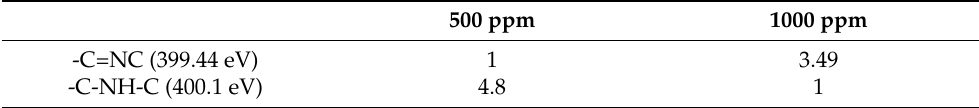
Table 4. The area ratio between –C=NC and –C-NH-C peaks from N 1s XPS